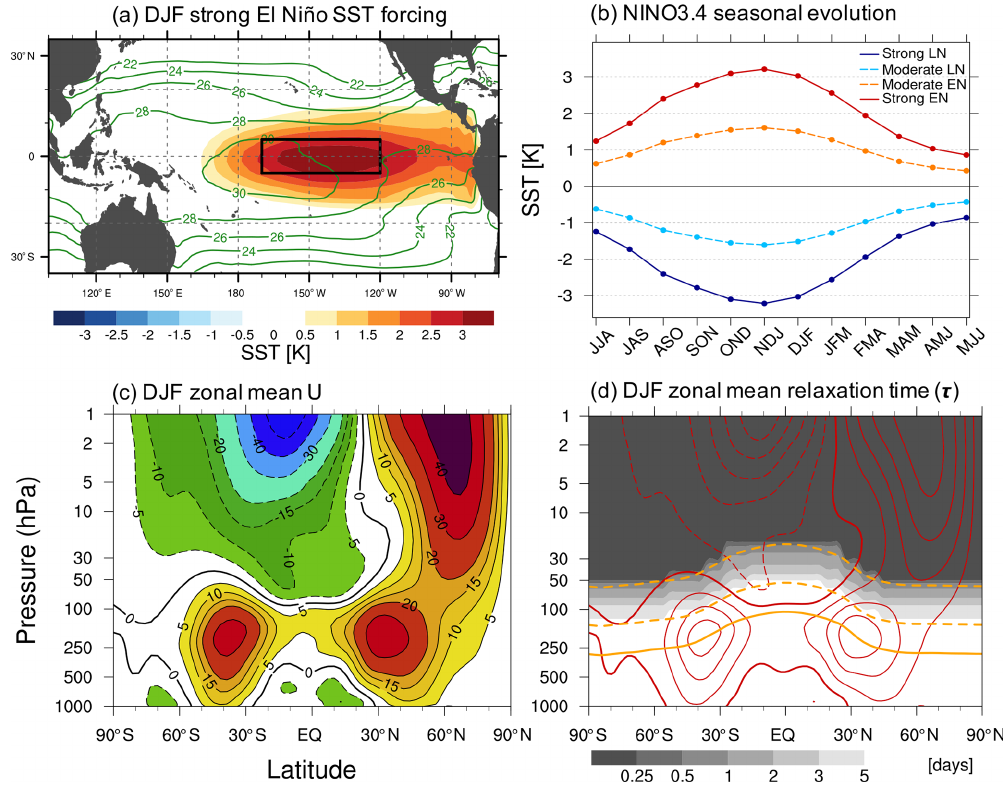
Figure 1. (a) DJF SST anomaly pattern in the tropical Pacific for the strong El Niño forcing simulation. (b) The seasonal evolution of the SST anomalies in the Nino3.4 region (black box in a ) for the four types of SST ENSO forcings. (c) The DJF zonal mean zonal wind ( U ) in the climatological SST simulation. (d) The DJF zonal mean relaxation timescale ( τ ) in days. In (d) , red contours represent U as in (c) , the solid orange line represents the DJF mean tropopause height, and the dashed orange lines represent the 0.5 p trop and 0.2 p trop levels, which denote the limits for the transition area of the